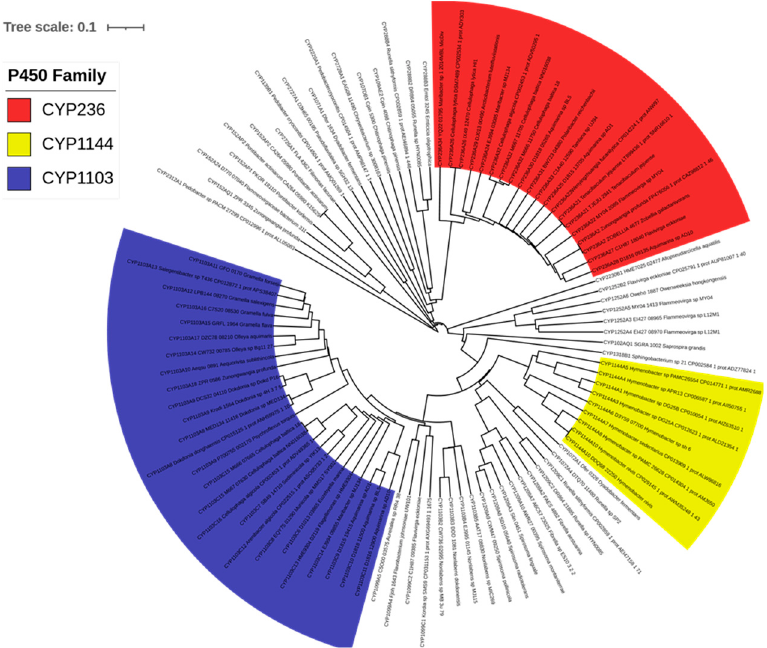
Figure 2. Phylogenetic analysis of Bacteroidetes species P450s. The P450 families that are expanded in these species are displayed in different colors.